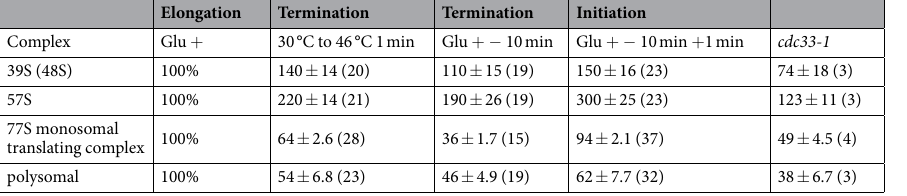
Table 1. Relative levels of 39S (48S) and 57S complexes following translational shut-off or initiation as detected with AU-A 230 analysis following Flag-PAB1 pull downs. The relative levels (in percentage) of the 39S (similar to the canonical 48S complex) and 57S complexes ( ± Standard Error of the Mean, S.E.M.) were compared to steady-state elongation conditions (Glu + ) (set at 100) following Flag-PAB1 pull downs and AU-A 230 analysis. The relative levels of the 77S monosomal translating complex and that of polysomes are given as comparisons and are taken from Wang et al . 2012 and 2016 8,25 . Translational repression was conducted either for 10 min by depleting glucose from the medium or by shifting glucose-grown cells to 46 °C for 1 min 25 . Reinitiation of translation was accomplished by adding glucose back to glucose depleted cultures for 1 min. The cdc33-1 alelle was grown at 37 °C for one hr and compared to the isogenic parent strain grown under the same conditions 8 . The number of samples for each analysis is in parenthesis after the S.E.M.